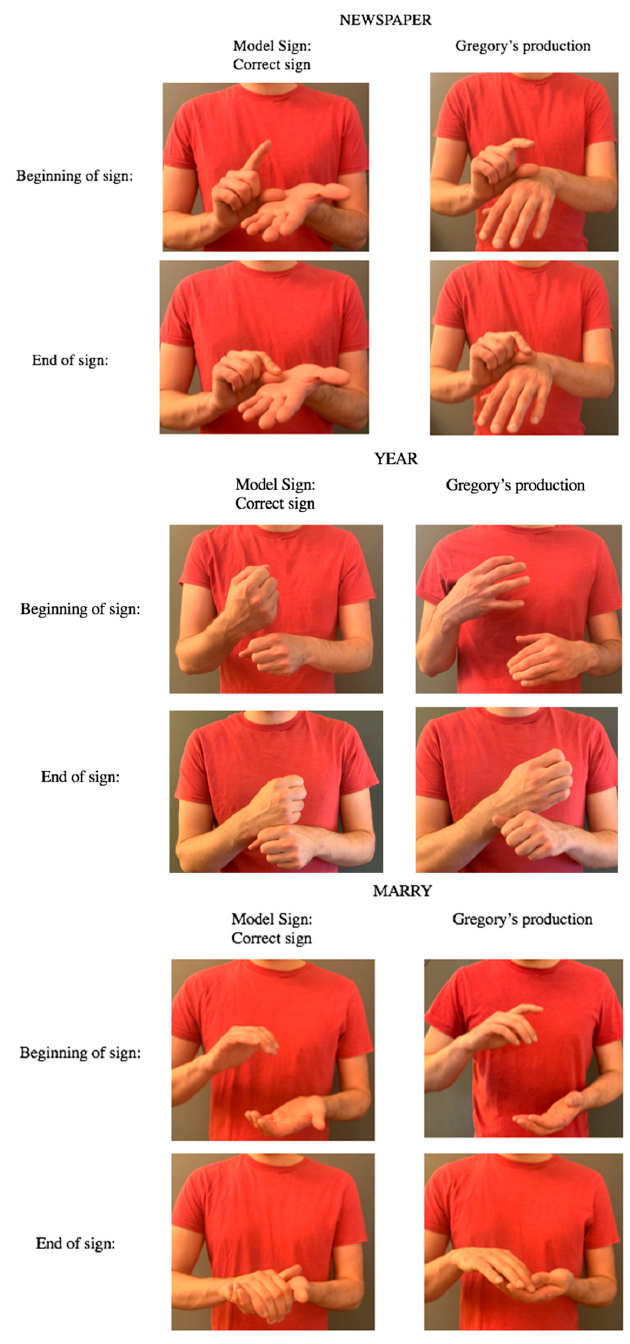
Figure 2. Examples of ASL-SRT stimuli signs versus Gregory’s productions.